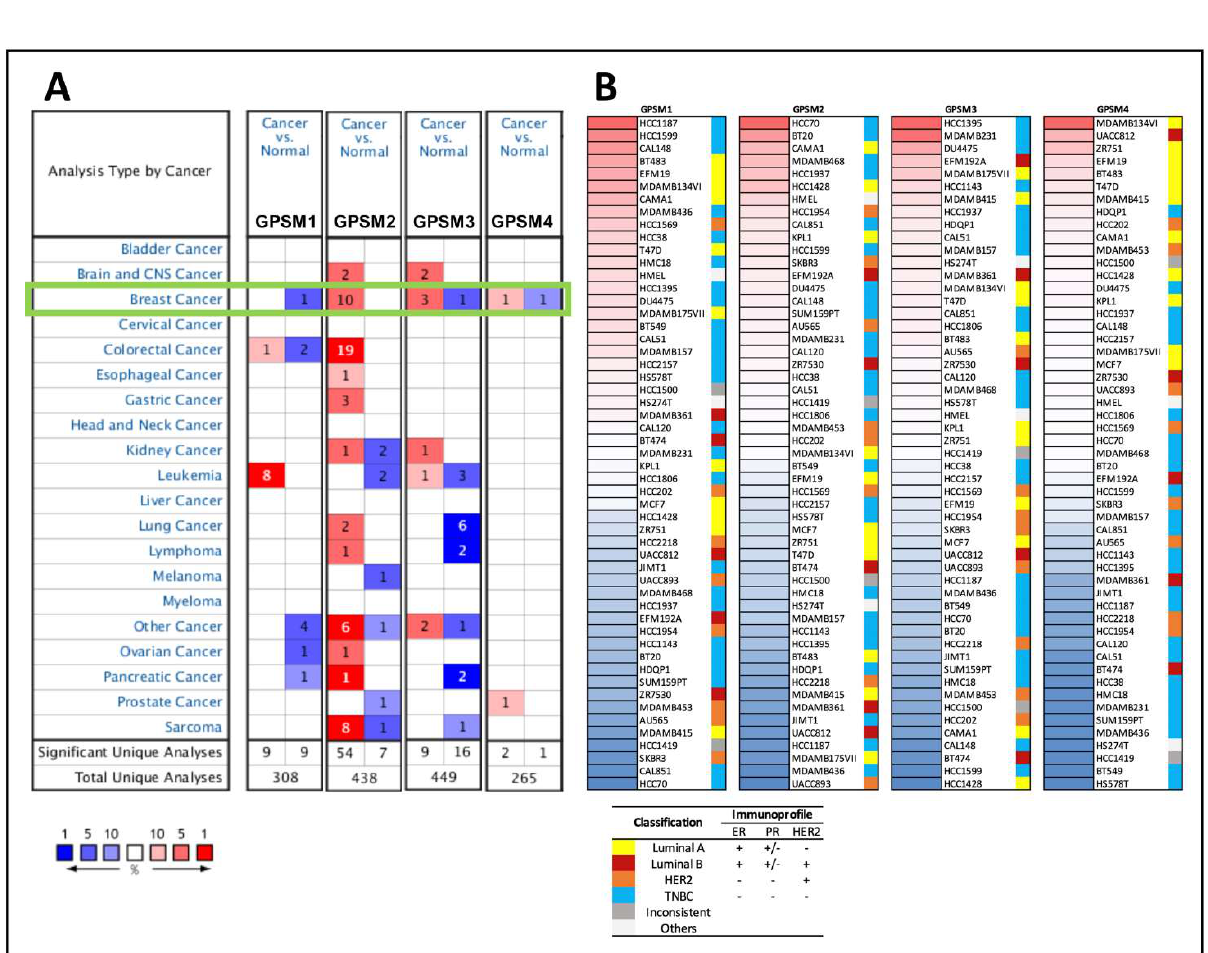
Figure 2. Expression of GPSMs across various cancer tissues. ( A ) mRNA expression levels of GPSMs in 20 cancer types. Numbers in red and blue cells represent dataset numbers in which levels of GPSMs are statistically increased or decreased, respectively ( p < 0.05, fold change >2, gene rank top 10%, Oncomine). ( B ) Heatmap plots showing GPSMs expression status in breast cancer cell lines (CCLE), with colored columns on the right side displaying the molecular subtype of each cell line. “Inconsistent” denotes cell lines that are inconsistently annotated regarding the status of markers. “Others” include two cell lines that were not breast cancer (HMEL, engineered breast and HS274T, breast fibroblast). TNBC, triple negative breast cancer.